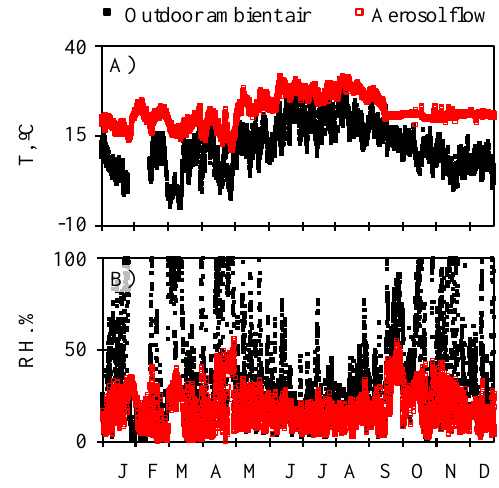
Fig. 2. Hourly mean values of temperature and relative humidity in the outdoor ambient air and in the aerosol flow of the SMPS during